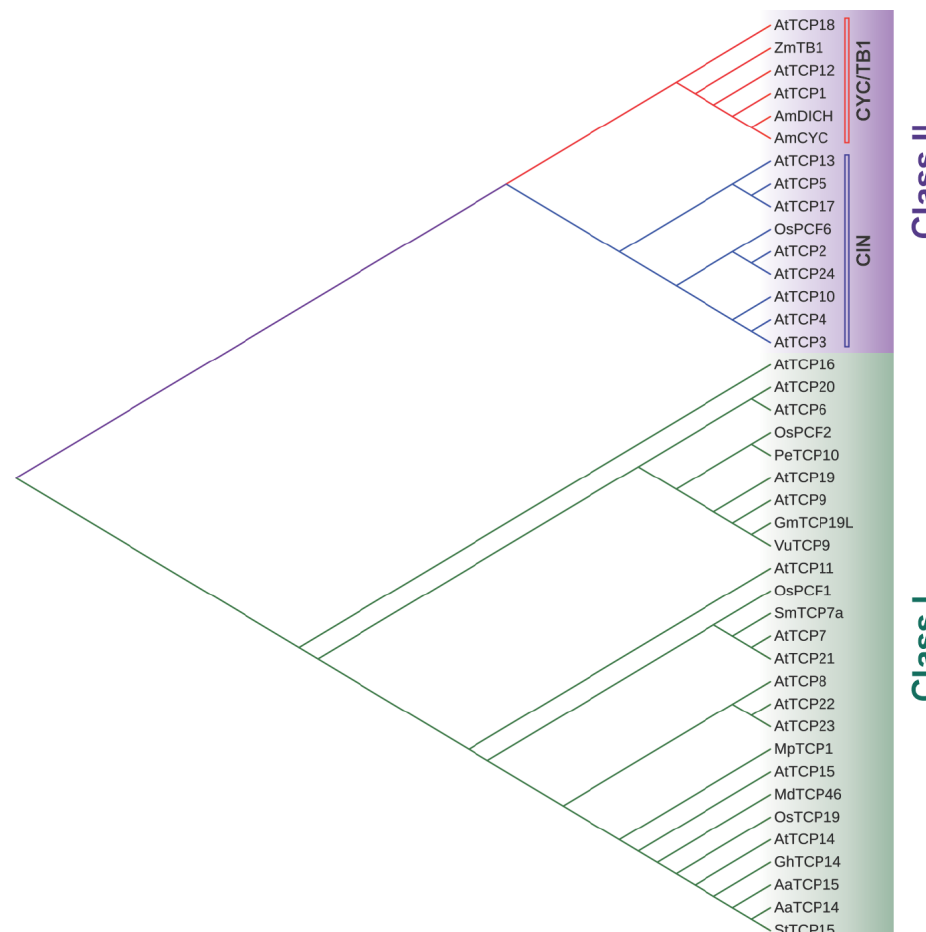
Figure 1. Phylogenetic tree of the TCP family showing the different classes (I and II) and clades (CYC/TB1 and CIN). Amino acid sequences of TCP proteins from Arabidopsis thaliana , the four founding members of the TCP family (ZmTB1, AmCYC, OsPCF1 and OsPCF2) and the other TCPs mentioned throughout this review were aligned with Clustal Omega (https://www.ebi. ac.uk/Tools/msa/clustalo/, accessed on 10 February 2023) and used to construct the tree using the Neighbor-Joining method (https://www.ebi.ac.uk/Tools/phylogeny/simple_phylogeny/, ac- cessed on 10 February 2023). The tree was displayed using iTOL (https://itol.embl.de/itol.cgi, accessed on 10 February 2023). At, Arabidopsis thaliana ; Am, Antirrhinum majus ; Zm, Zea mays ; Os, Oryza sativa ; Gh, Gossypium hirsutum ; Aa, Artemisia annua ; Gm, Glycine max ; Sm, Solanum melongena